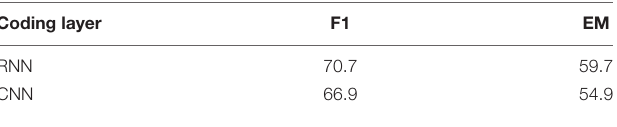
TABLE 7 | Comparison of exact match (EM) and F1 scores of baseline model and improved model.